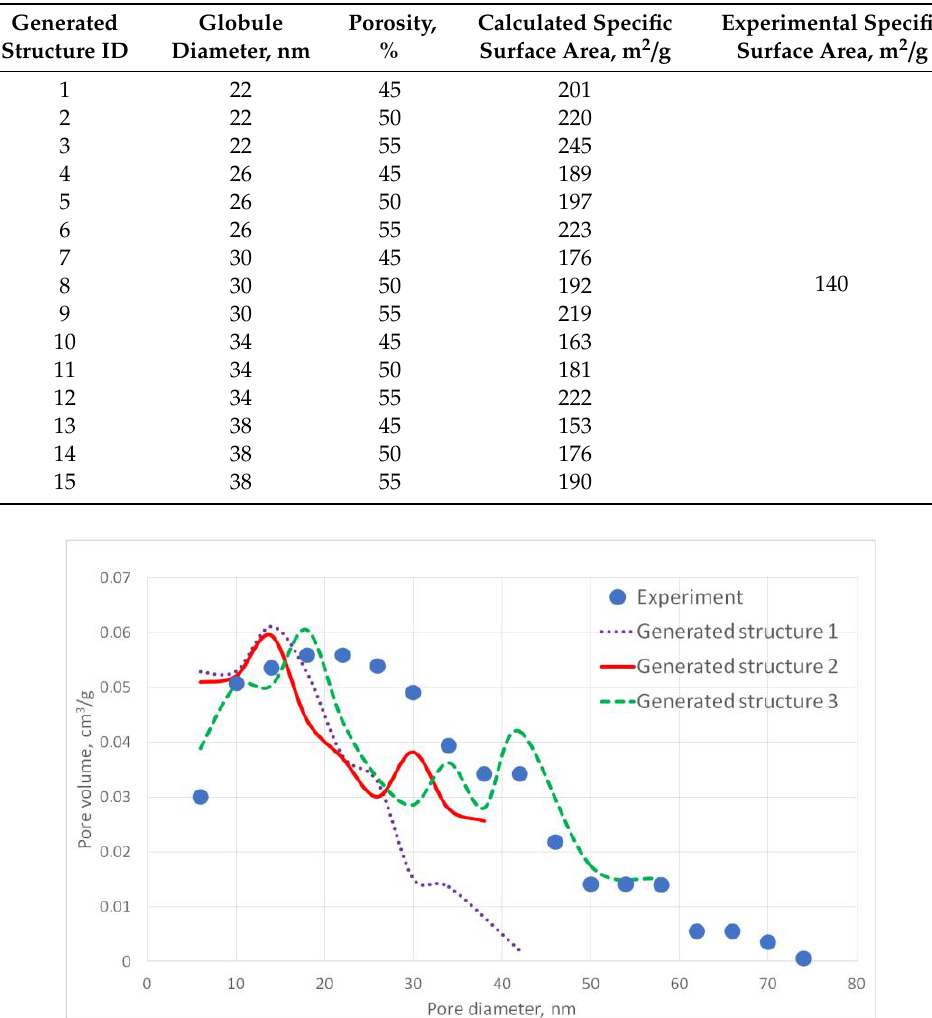
Table 1. DLCA model parameters for polyamide aerogel structure generation and specific surface area of generated structures.